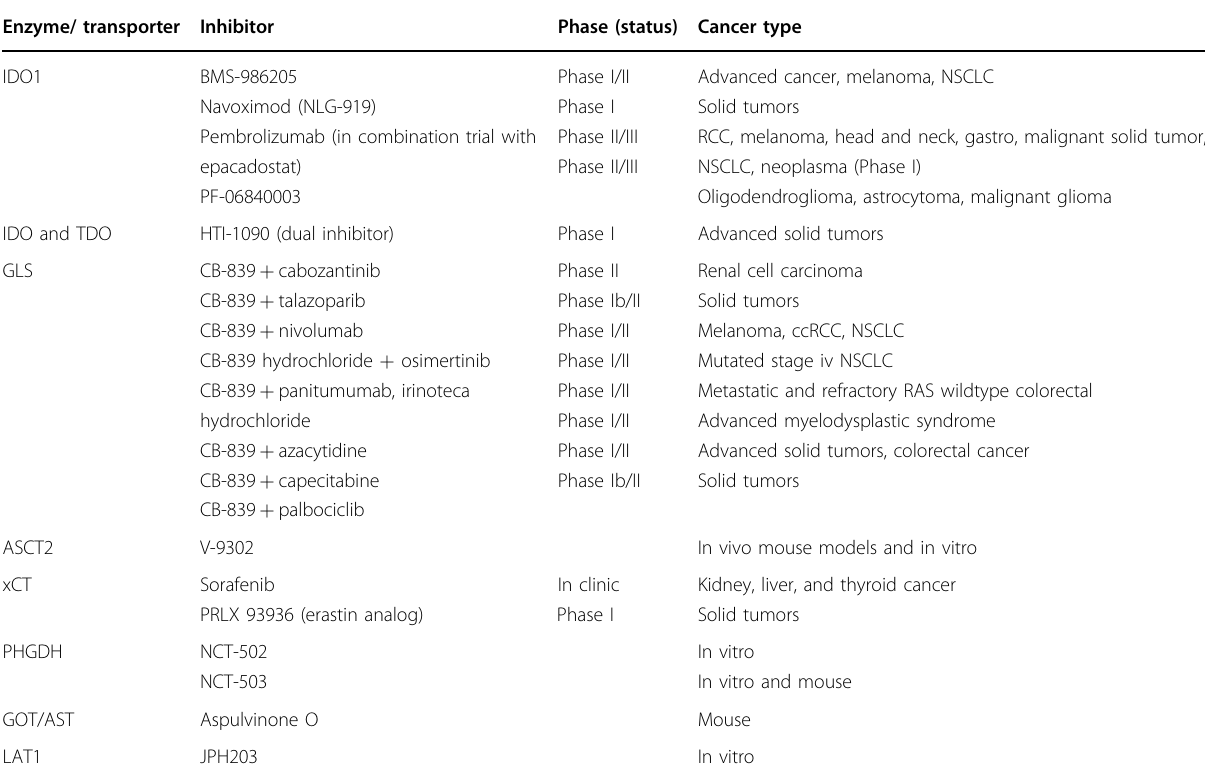
Table 1 Select agents targeting amino acid metabolism that are developed, in trials or in the clinic, for the treatment of